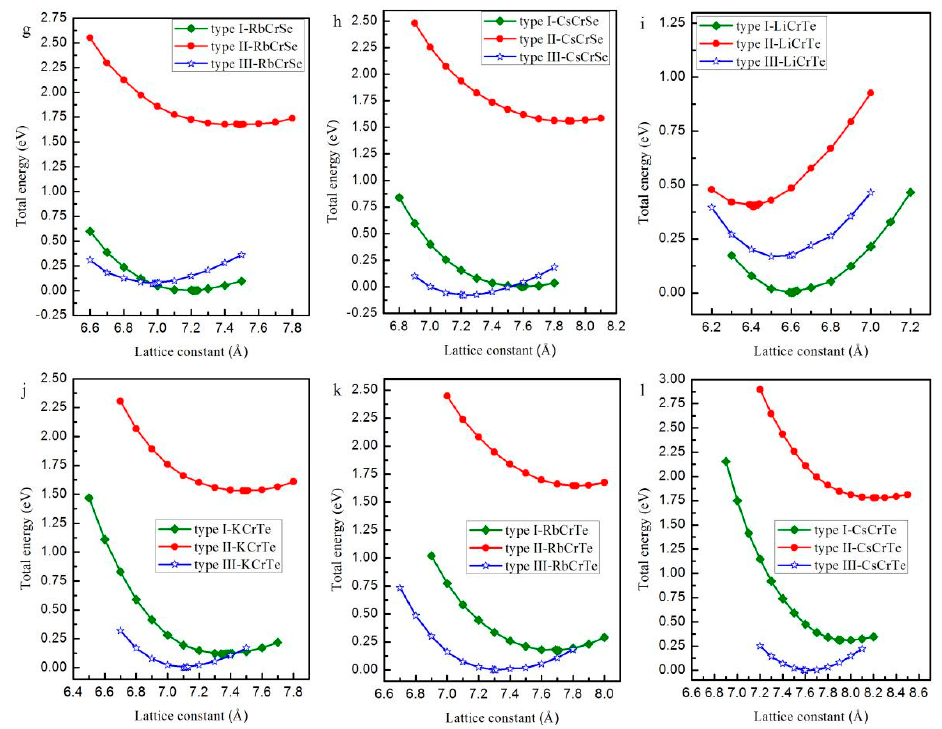
Figure 2. The total energy as a function of the lattice constant in the three atomic arrangements type I, type II, and type III for half-Heusler alloys LiCrS ( a ); KCrS ( b ); RbCrS ( c ); CsCrS ( d ); LiCrSe ( e ); KCrSe ( f ); RbCrSe ( g ); CsCrSe ( h ); LiCrTe ( i ); KCrTe ( j ); RbCrTe ( k ) and CsCrTe ( l ), respectively. Table 1. Optimized lattice constants (a), calculated total and the atomic magnetic moments (M t ) per formula unit, and sizes of the semiconducting-type band-gap (Gap) at different crystal structures for XCrZ (X = Li, K, Rb, Cs; Z = S, Se, Te). Yes (or no) indicates that this alloy is (or is not) a half metal.